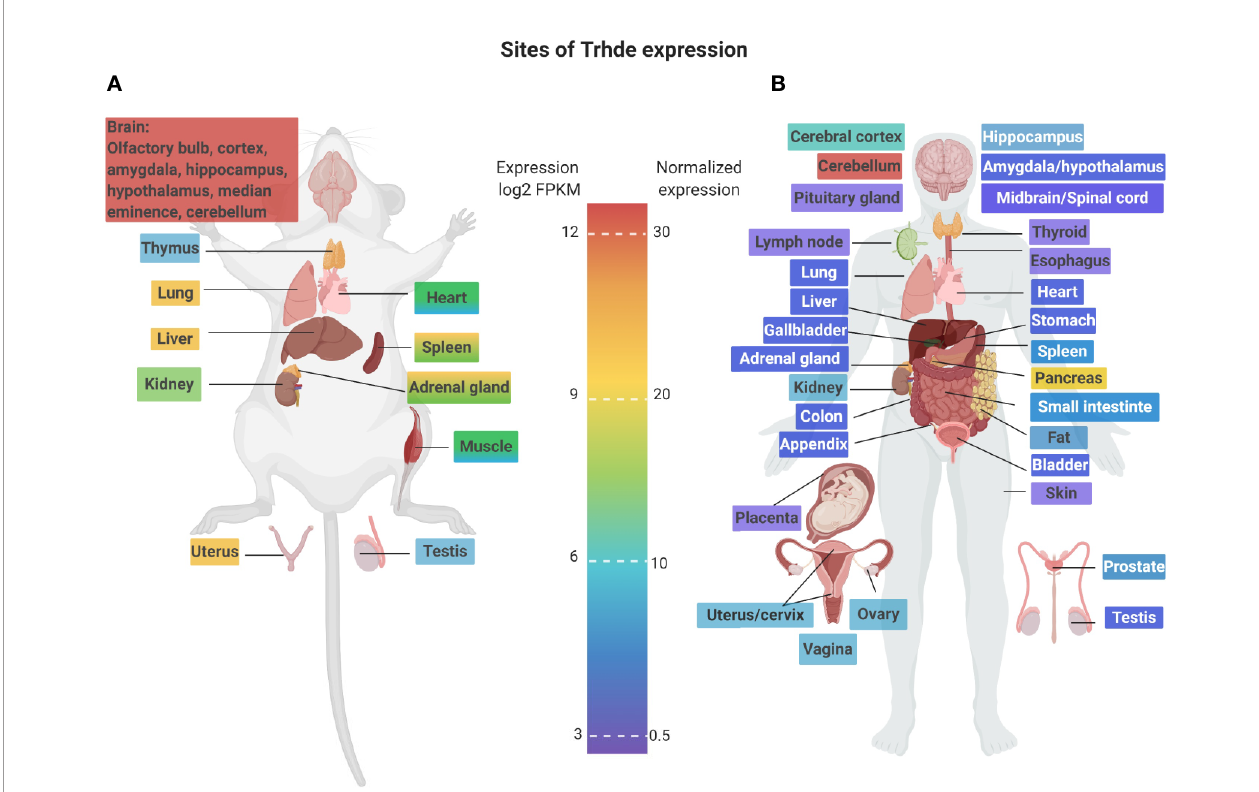
FIGURE 3 | Potential sites of targeting of TRH-DE in rats and humans. Trhde is mainly expressed in a few major organs; in rats, gene expression is higher in brain followed by lung, liver and uterus; in humans, major sites of expression are cerebellum and pancreas. Panel (A) illustrates tissue Trhde expression distribution in rat (log2 FPKM, fragments per kilobase of transcript per million mapped reads) based on the database of the rat body map available from http://pgx.fudan.edu.cn/ ratbodymap/index.html (Yu et al., 2014); some of the brain regions which express medium (i.e. hypothalamus) to high mRNA levels are also indicated (Heuer et al., 1998b). Panel (B) illustrates tissue Trhde expression distribution in humans based on the Human Protein Atlas available from http://www.proteinatlas.org (Uhle ́ n et al., 2015). Colors on organ/tissue names represent expression levels of Trhde . Information regarding sex and age of the donor, can be found at http://www. proteinatlas.org/about/cellines. Figure was created with